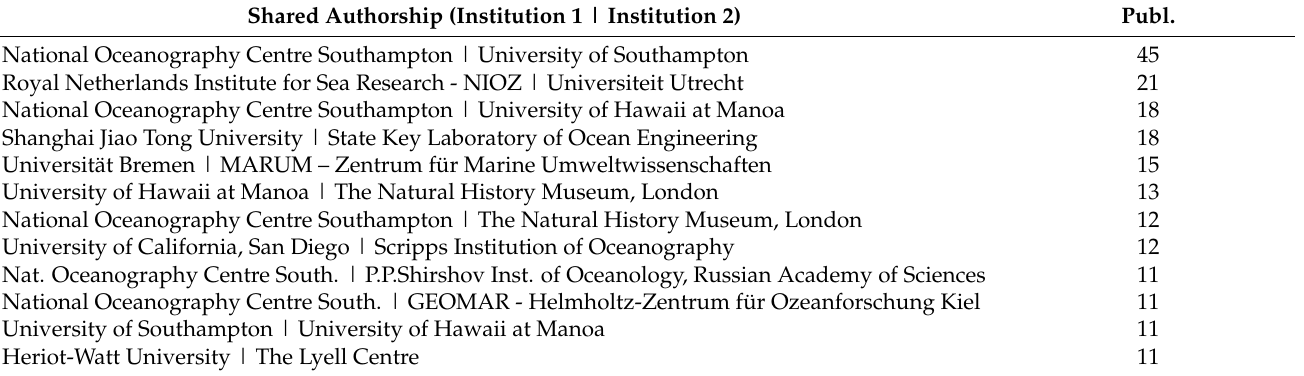
Table 6. Number of shared authorship publications between pairs of institutions (2017–2021). The table shows all pairs representing more than 10